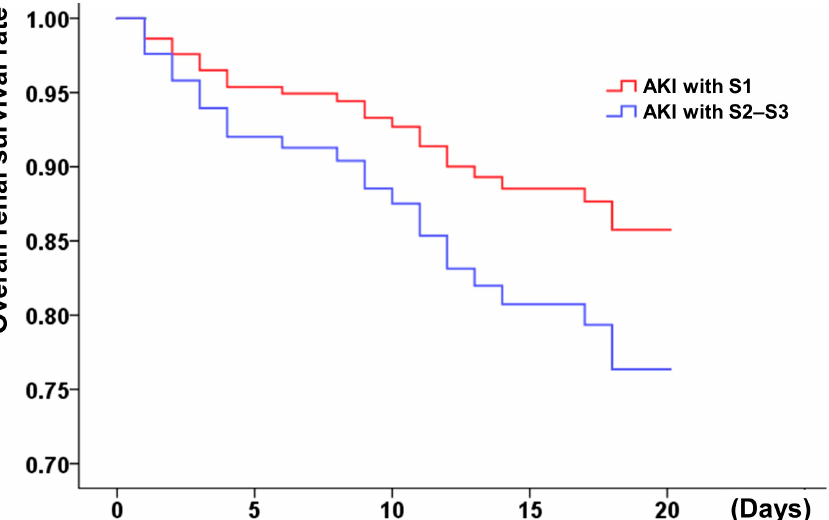
Figure 2. Hemodialysis-free survival of MI patients with different AKI stages (S1: stage 1; S2–S3: stage 2 or 3). AKI stage 1 as serum creatinine 1.5–1.9 times baseline or ≥ 0.3 mg/dL increment or urine output <0.5 mL/kg/h for 6–12 h; stage 2 as serum creatinine 2.0–2.9 times baseline or urine output <0.5 mL/kg/h for more than 12 h; stage 3 as serum creatinine more than 3.0 times baseline or increment in serum creatinine to ≥ 4.0 mg/dL or initiation of renal replacement therapy or urine output less than 0.3mL/kg/h for ≥ 24 h, or anuria more than 12